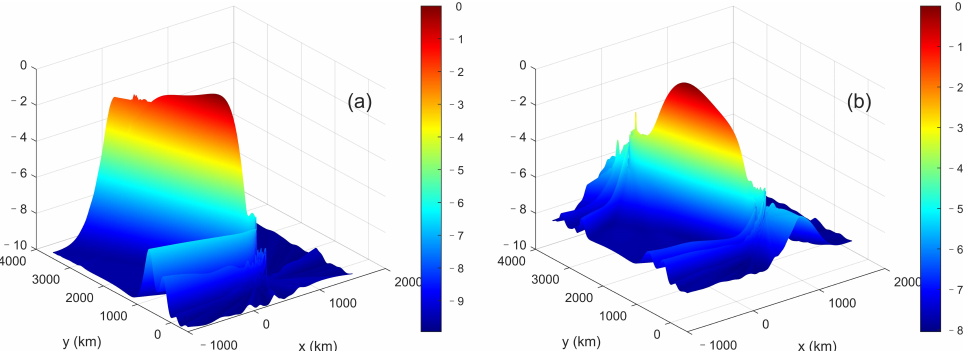
Figure 4. (Color online) 3D spatial spectrum of GMA ( a ) and N-MUSIC ( b ) with 127 Hz at segment